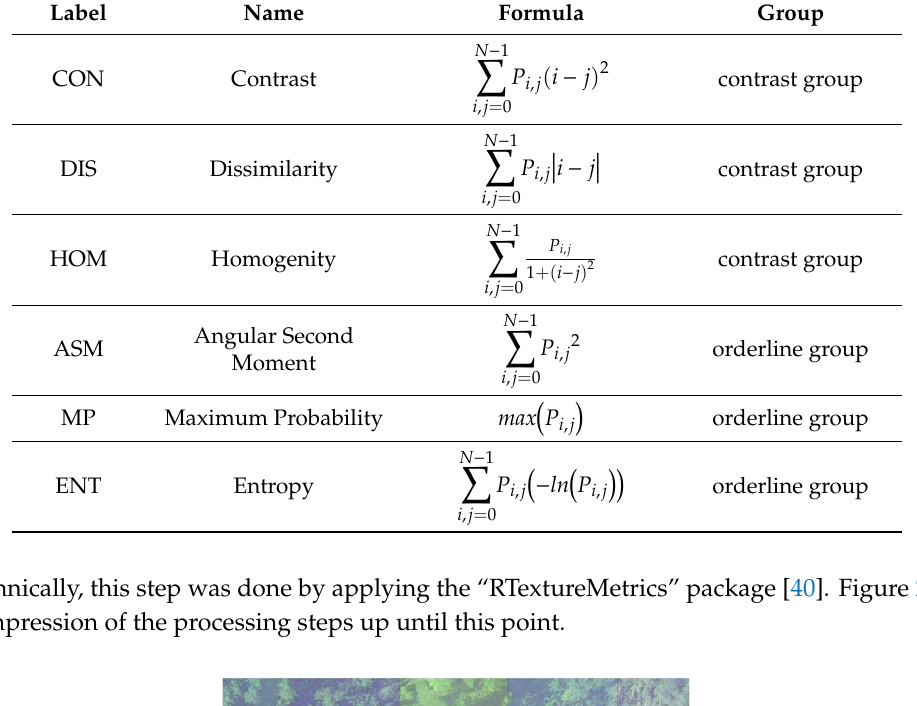
Table 3. List of the applied texture metrics.